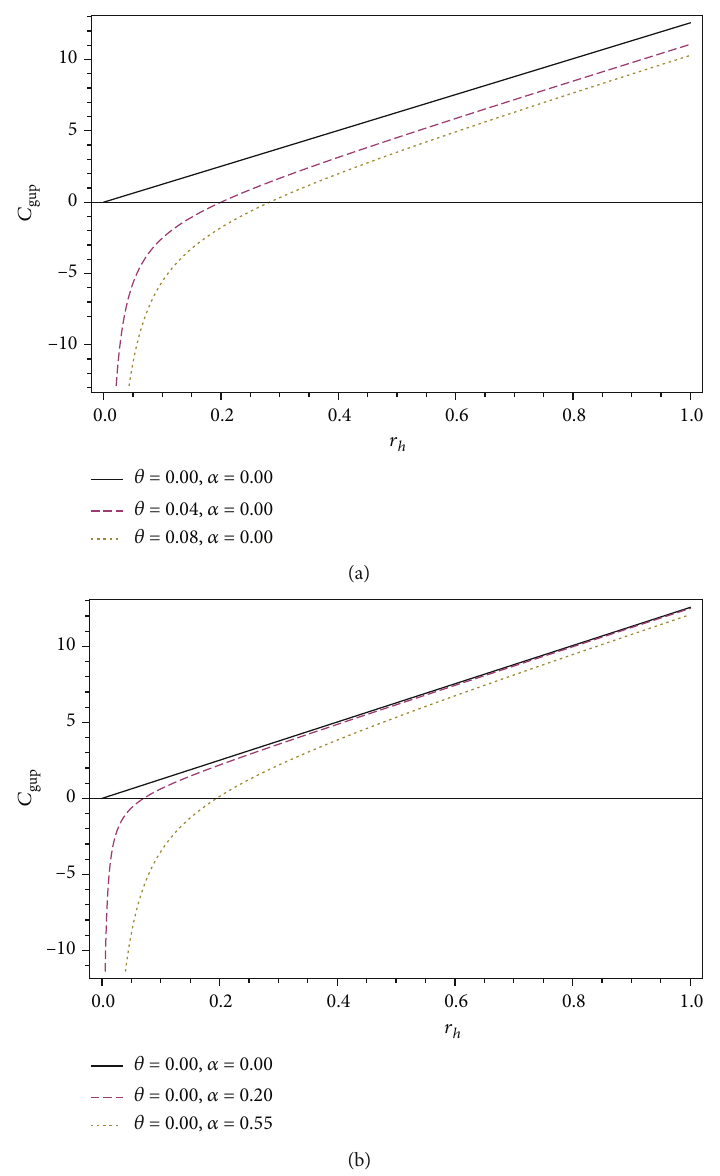
Figure 2: Speci fi c heat capacity. (a) For θ ≠ 0 and α = 0 , we have the result for the speci fi c heat of the noncommutative BTZ black hole. (b) For θ = 0 and α ≠ 0 , we have the result for the speci fi c heat of the commutative BTZ black hole with